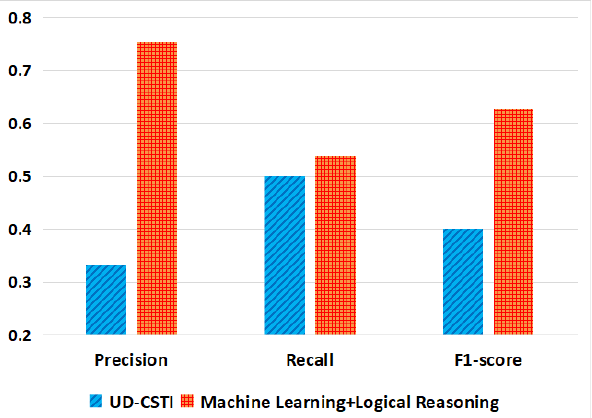
Figure 18. The result of comparing our proposed approach with methods proposed by related researchers on the SMOS